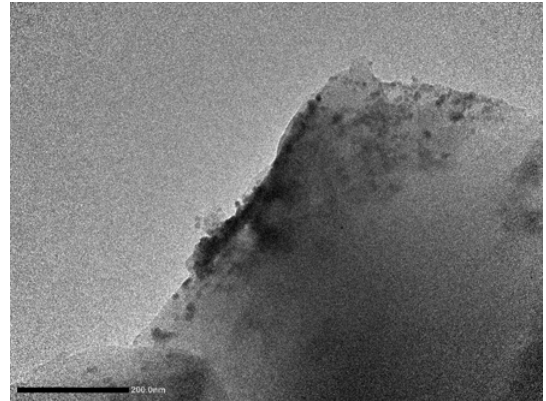
Figure 10. Agglomeration on the fracture surface of epoxy resin modified with 7 wt % of 50 nm.